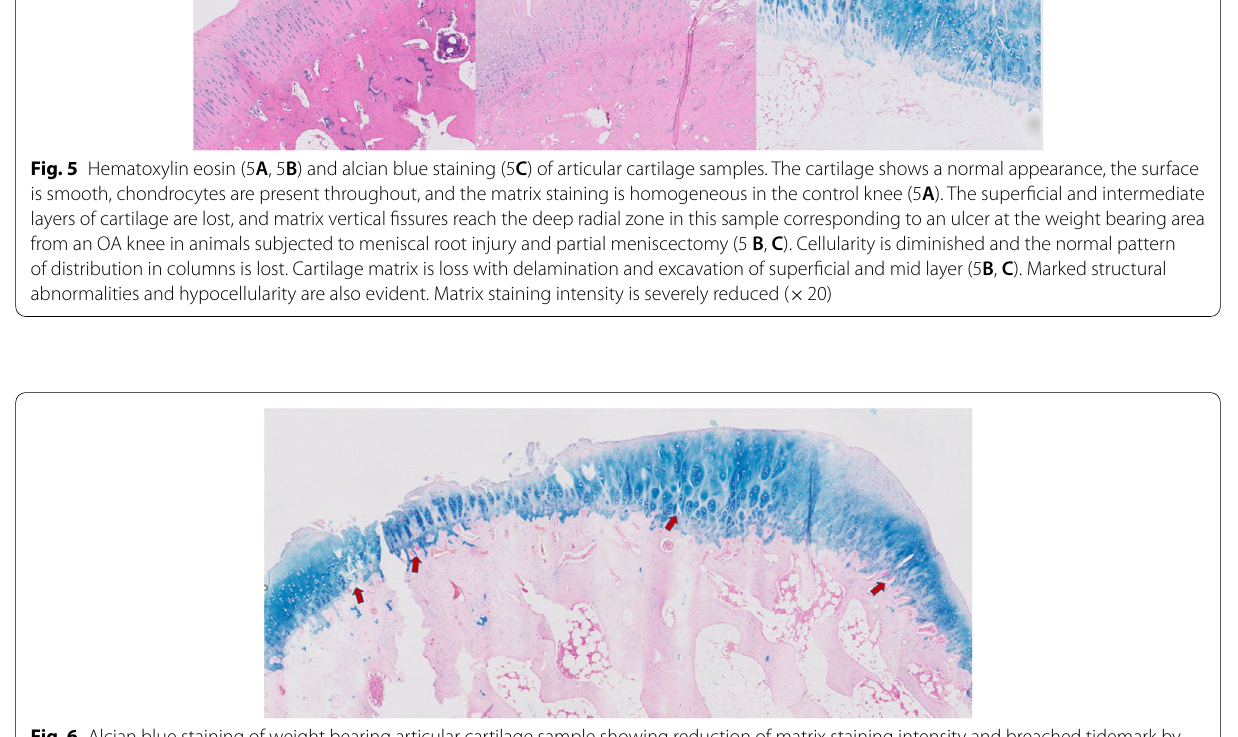
Fig. 6 Alcian blue staining of weight bearing articular cartilage sample showing reduction of matrix staining intensity and breached tidemark by blood vessels and with minor splits (red arrows) compromising the integrity of the junction between the calcified and the noncalcified